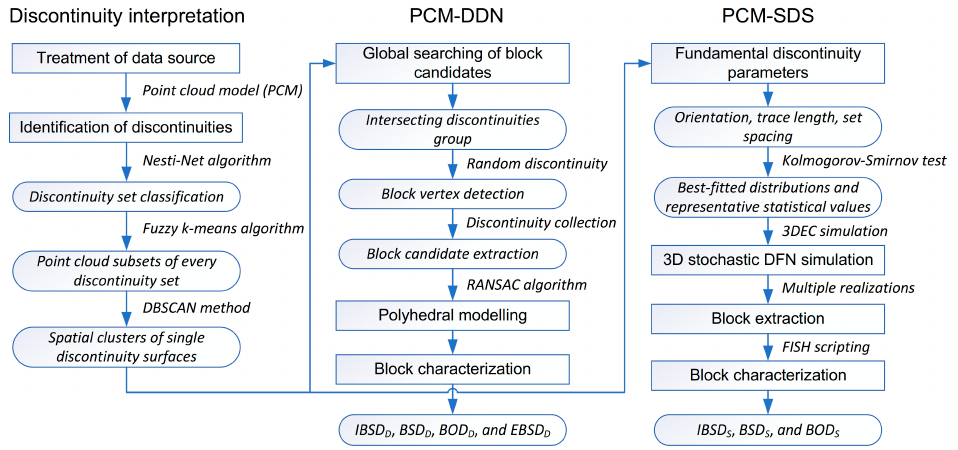
Figure 4. Flow chart of the proposed method.